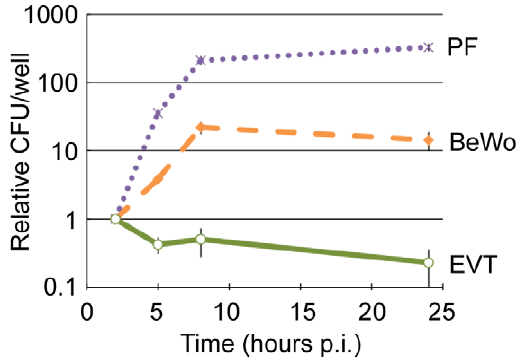
Figure 2. EVT restrict intracellular growth of L.monocytogenes . Intracellular growth curves of wild type L. monocytogenes in 3 cell types: primary placental fibroblasts (PF), choriocarcinoma cell line (BeWo), and primary extravillous trophoblasts (EVT). CFU/well were normalized to the 2-hour time point within each experiment. Each data point is an average of 3 independent experiments for PF and BeWo, and 10 independent experiments for EVT. Bars represent SEM.